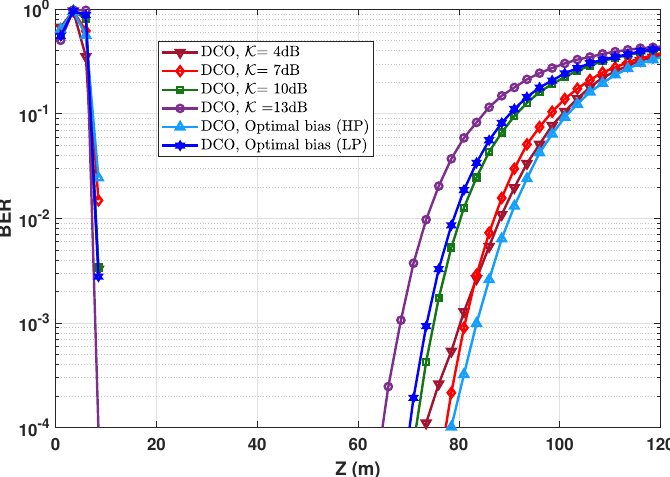
Figure A3. Comparison of the BER performance for DCO-OFDM obtained using low- and high-precision (LP and HP) optimal bias calculation with those calculated based on clipping factors of 4, 7, 10, and 13dB. P Tx,e = 50mW; N = 1024; N CP = 9; R b = 20Mbps, η ≈